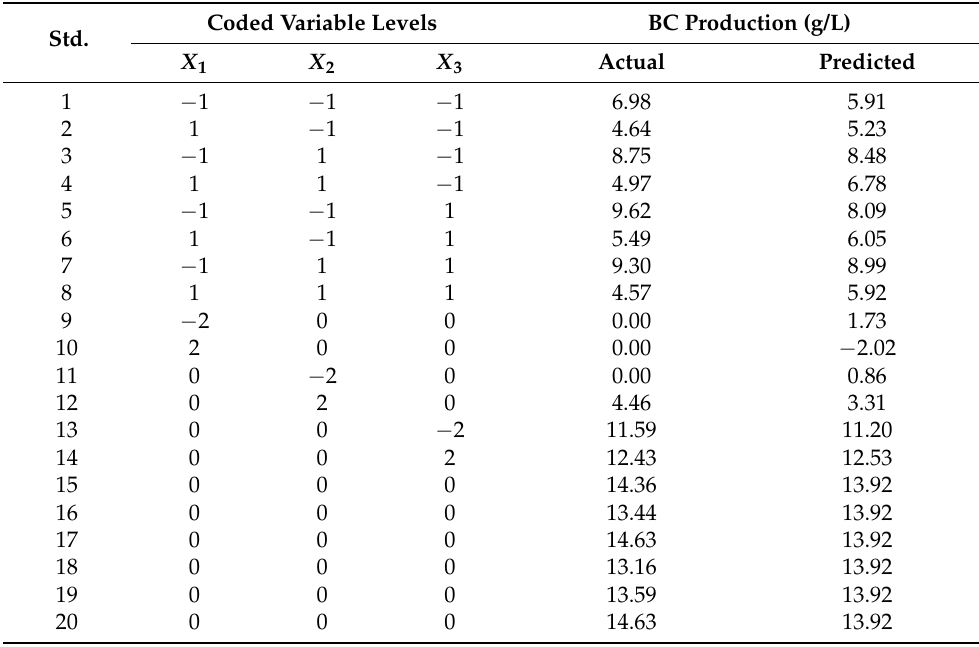
Table 2. The designed experimental plan and the result values for five-level, three-variable response surface analysis. Coded Variable Levels BC Production Std.